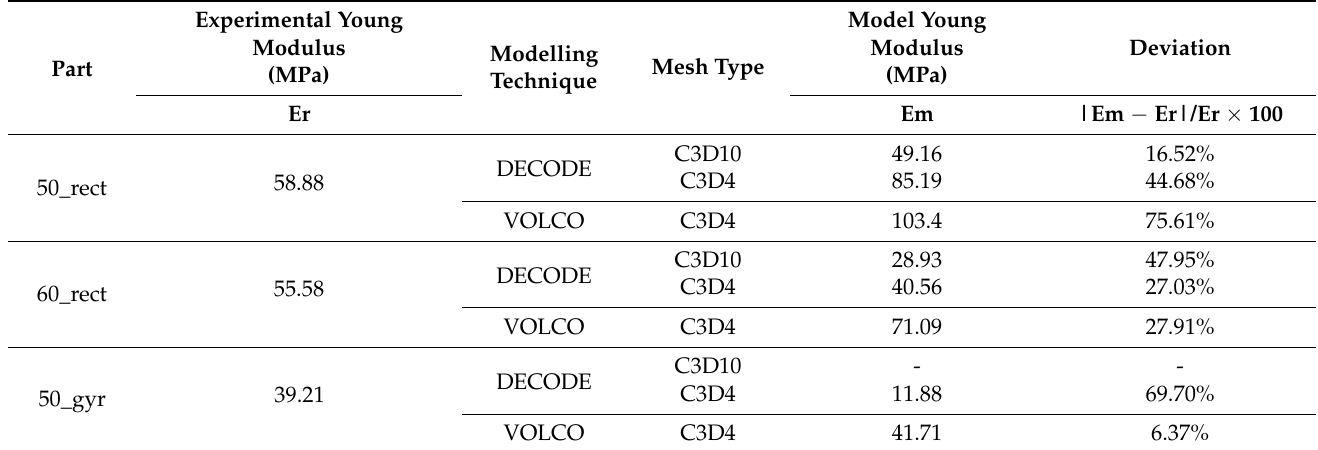
Table 11. Comparison of Elastic